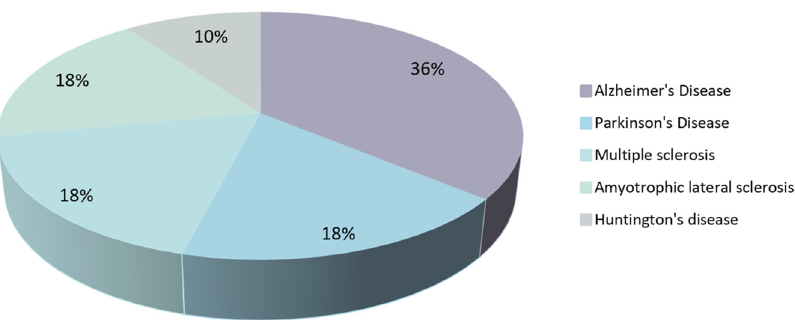
Figure 1. Schematic distribution of the number of natural compounds studied in clinical trials by the targeted disease. The graph was created based on the clinical trials reported in this review.